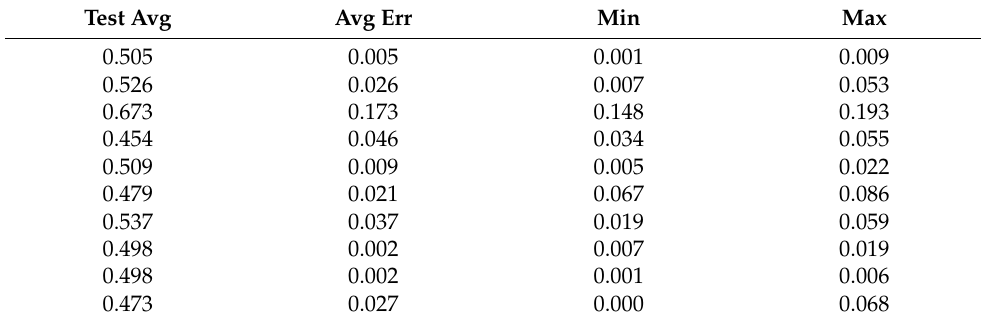
Table A85. Set 2, trials 1–10 data (all 0.5 PR values).